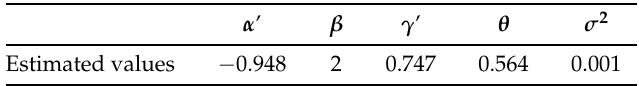
Table 4. Results for simulated lognormal oscillabolastic diffusion. α ’ β γ ’ θ σ 2 Estimated values − 0.948 2 0.747 0.564 0.001